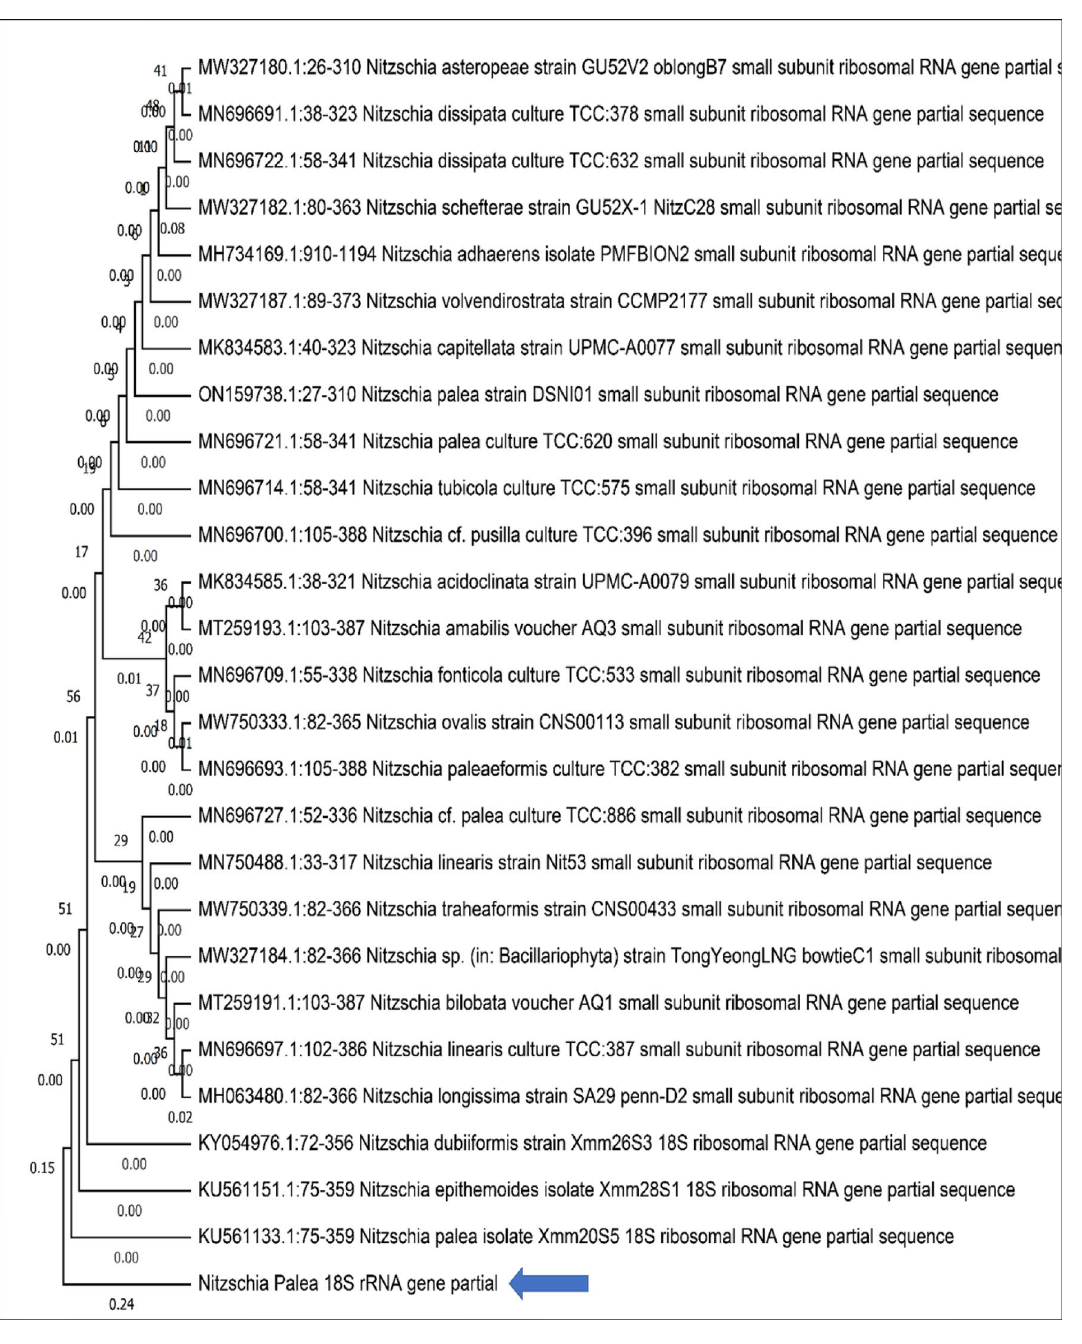
Figure 6. Phylogenetic tree constructed for 18S rRNA gene smaller subunit (denoted in Blue Arrow) based on Neighbour-joining statistical